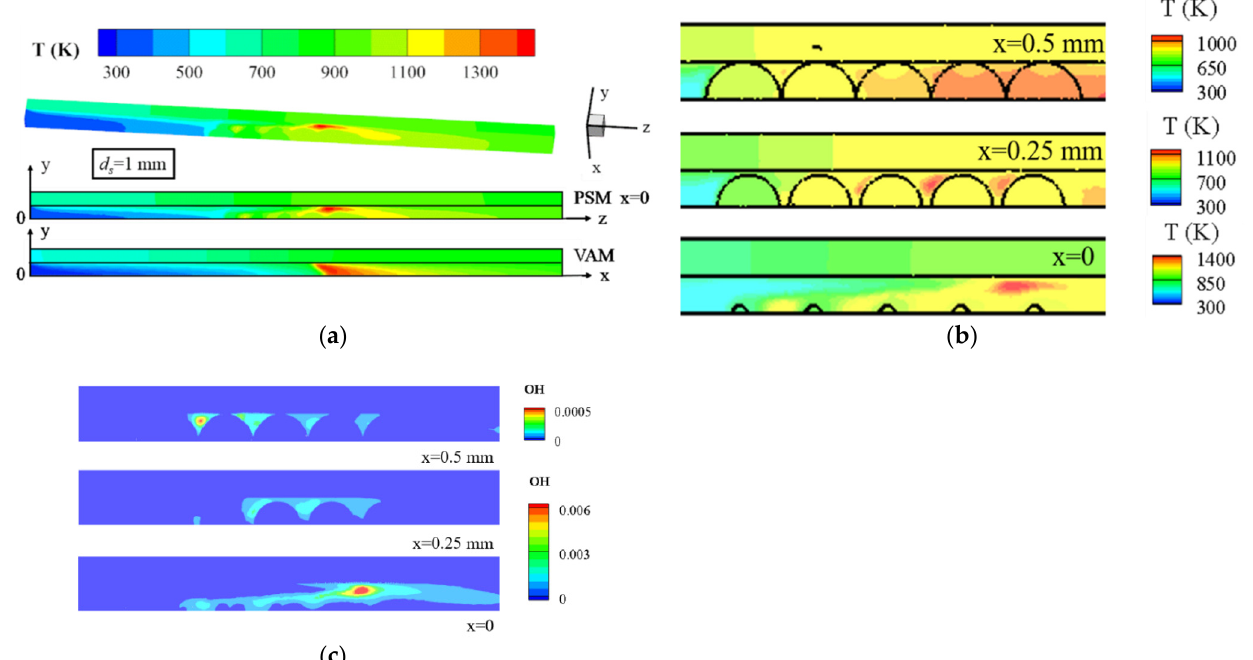
Figure 4. Temperature distribution and OH concentration obtained by the VAM and PSM, with U 0 = 2 m/s, Φ = 0.65, and d s = 1.0 mm. ( a ) Local temperature distribution obtained by the VAM and PSM; ( b ) temperature distribution obtained by the PSM; ( c ) OH concentration obtained by the PSM.